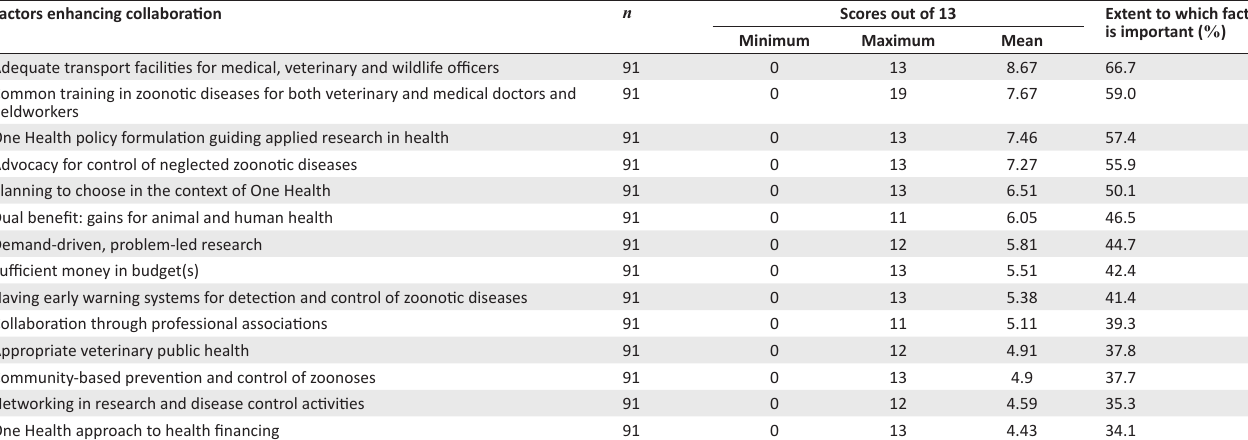
TABLE 2: Views on extent to which general factors enhance collaboration. Factors enhancing collaboration